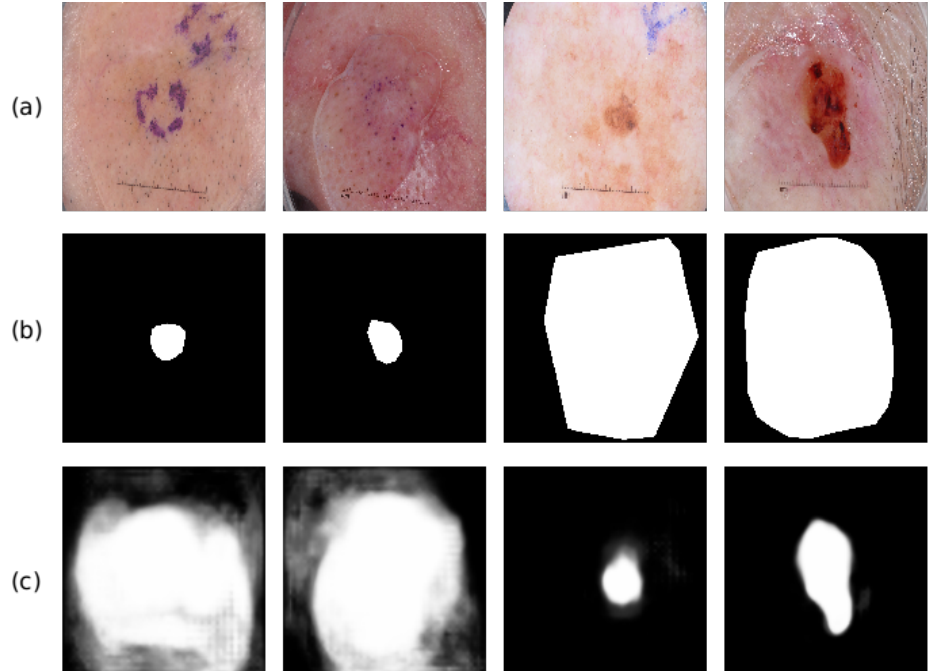
Figure 7. Some examples about the failed cases for the proposed method. ( a ) the input test im- ages; ( b ) the corresponding ground truth segmentation masks; ( c ) the probability map of the pro- posed